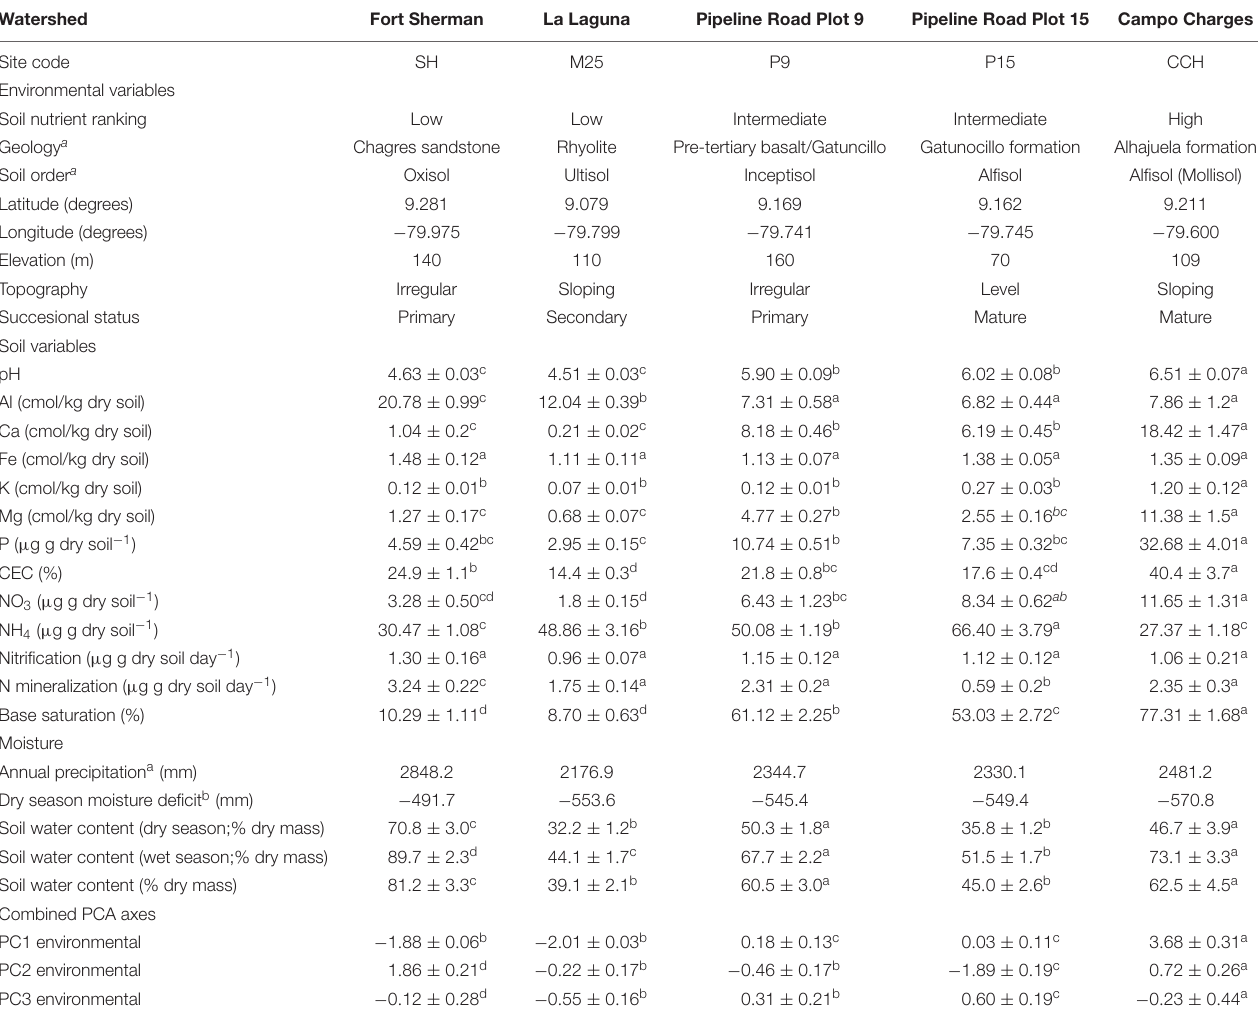
TABLE 1 | Environmental conditions and plot locations of five sites along a soil nutrient gradient in lowland tropical forests of the Panama Canal Watershed. Watershed